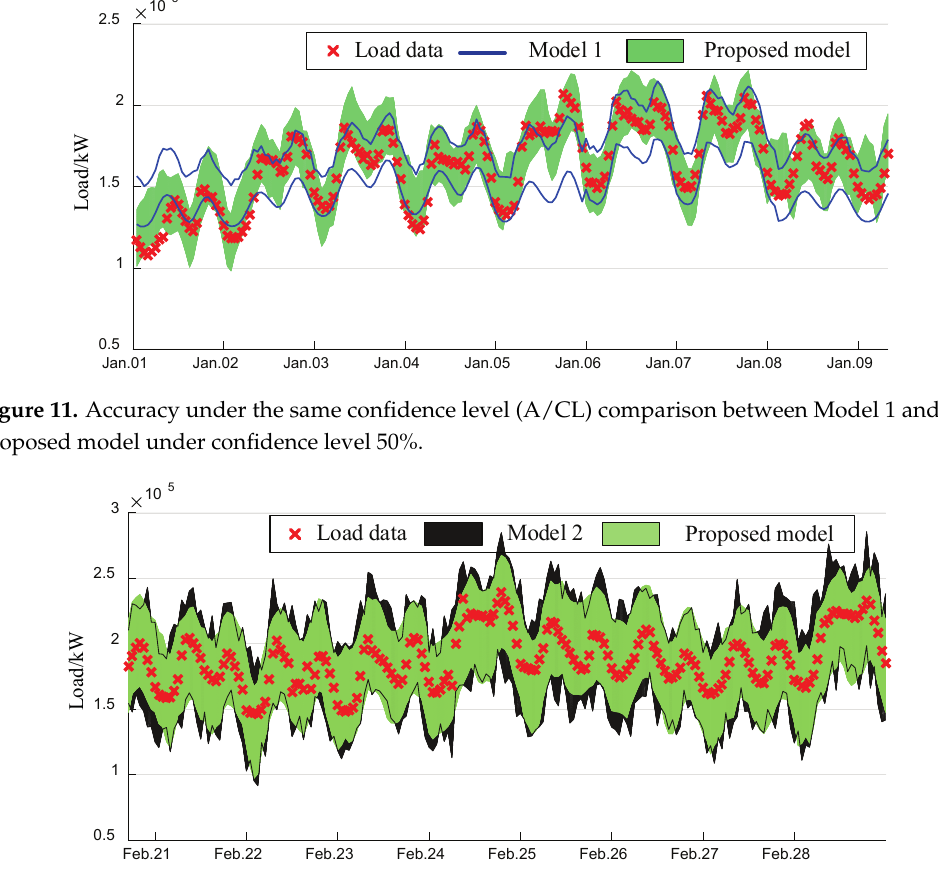
Figure 12. Uncertainty under equal accuracy (U/A) comparison between Model 2 and the proposed model under accuracy